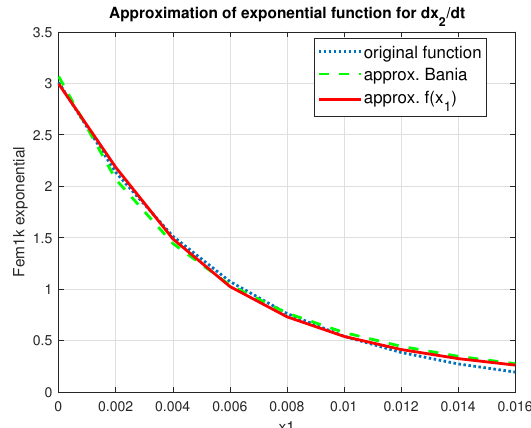
, comparison with dt